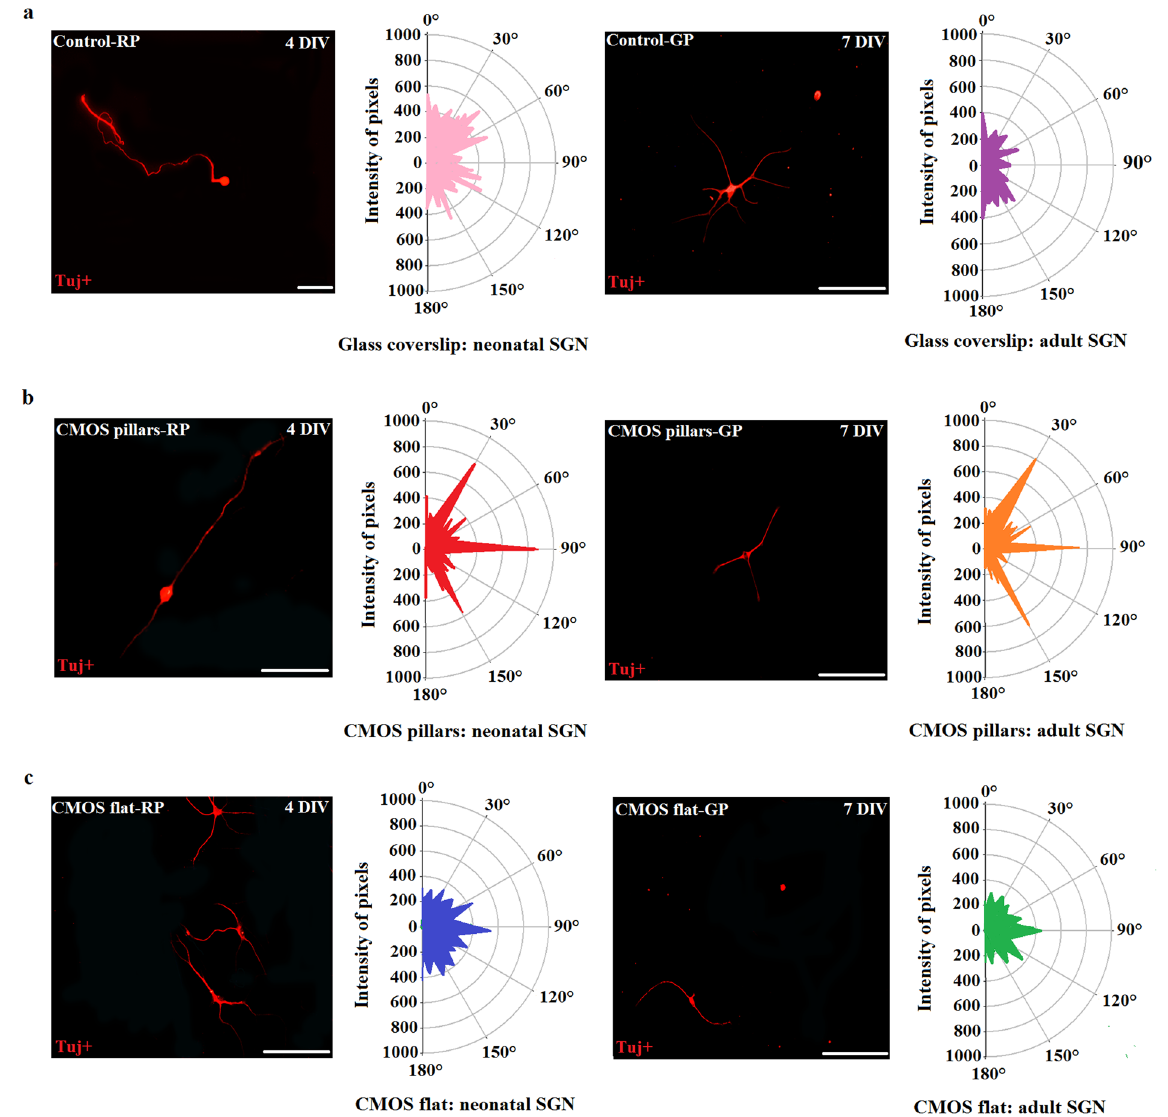
Figure 6. The effect of CMOS topography on neurite orientation and alignment. Representative fluorescent images of Tuj + neonatal and adult SGN alignment as well as alignment profiles of neurite growth around the preferred angles on glass coverslips ( a ), CMOS micro-patterned surfaces ( b ) and CMOS flat surfaces ( c ). RP = rat pups, GP = guinea pigs. Scale bars: 200 μ m. The radial values range from 0–1000 representing the intensity of pixels from FFT images along the same angle, while the angles are from 0 to 180 degrees. The values obtained by FFT Oval Profile picture analysis were averaged across neurons. For the control, 77 neonatal and 42 adult SGNs were analyzed. (N = 18), For CMOS micro-patterned surfaces, 203 neonatal and 162 adult SGNs were analyzed (N = 18) and for CMOS flat surfaces, 134 neonatal SGN and 87 adult SGNs were analyzed (N =